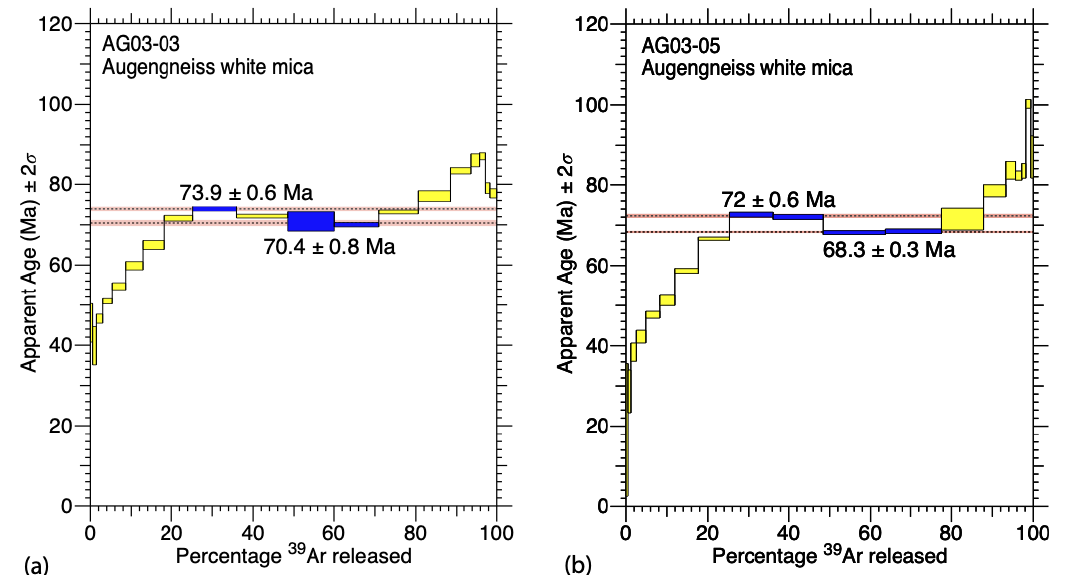
Figure 10. White mica age spectra from the structurally lowest augengneiss core (AG03-03, AG03-05). The complex age spectra are a result of multiple argon populations degassing at different temperature during the step-heating experiment. The augengneiss basement was subjected to multiple deformation events, but a significant argon population is derived from phengite with Late Cretaceous ages preserved. The argon geochronology data were published in Forster and Lister (2009) and re-analysed in this